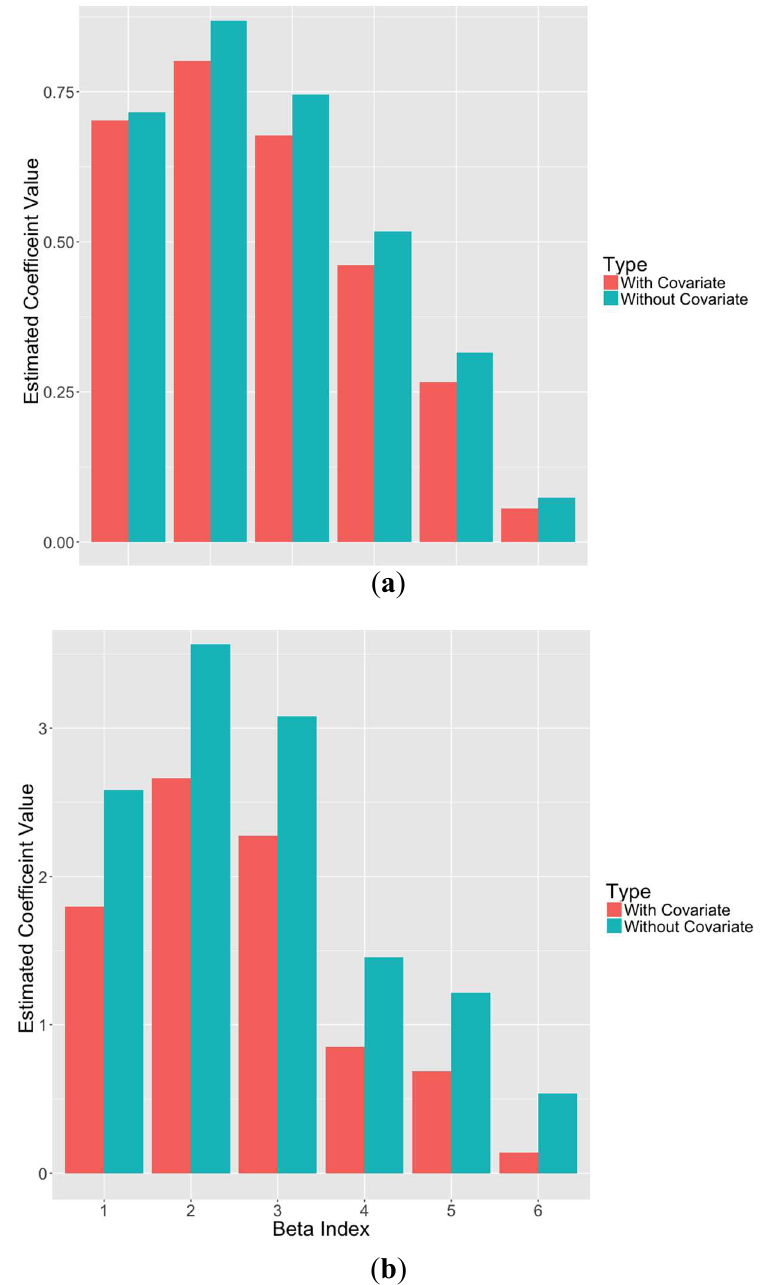
Figure 5. Estimated coefficient values for Bayesian Lasso models with and without the soil type covariate for SOC ( a ) and sand content ( b ). Please refer to Table 3 for the number of EPO and PLS factors.